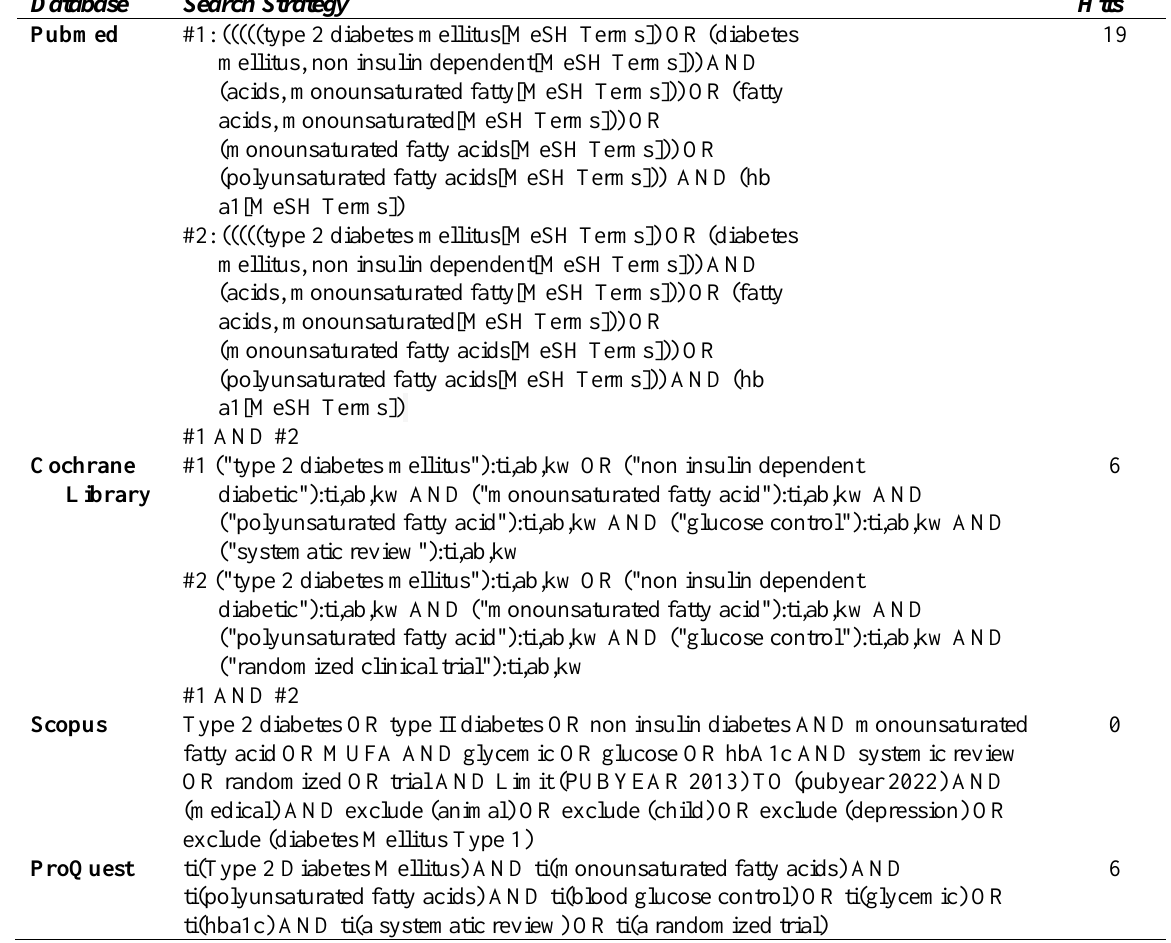
Table 1 Literature searching strategy